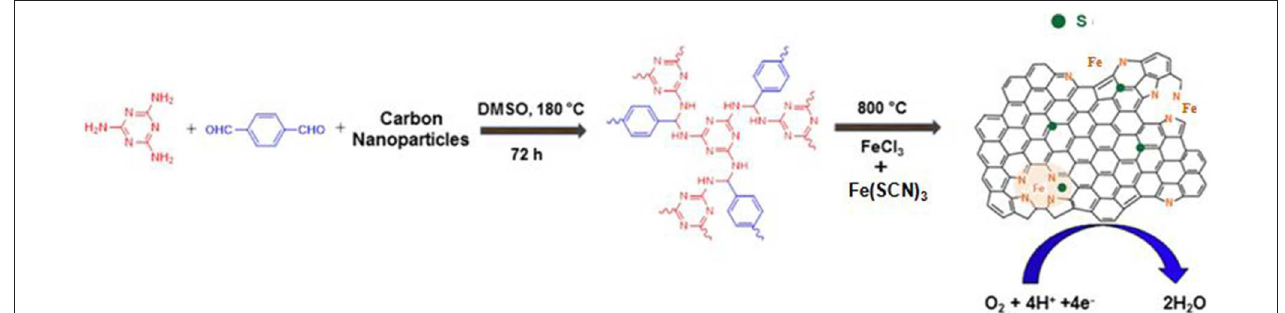
FIGURE 1 | The summary of synthesis of dual-doped electrocatalysts.